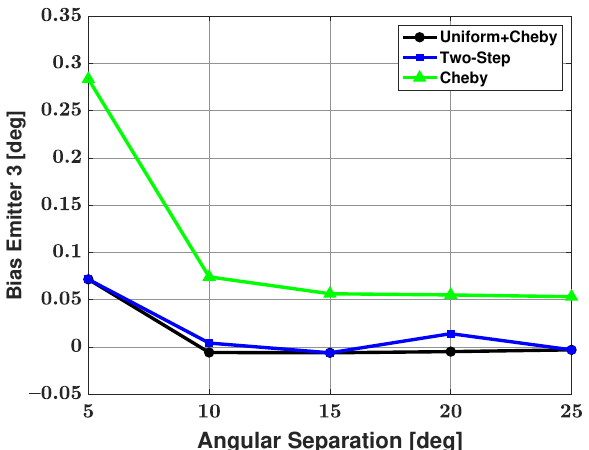
Figure 8. Bias in the estimated direction of the third, weakest emitter versus angular separation between emitters #2 and #3: the three proposed methods are used for estimation; SNR of emitter